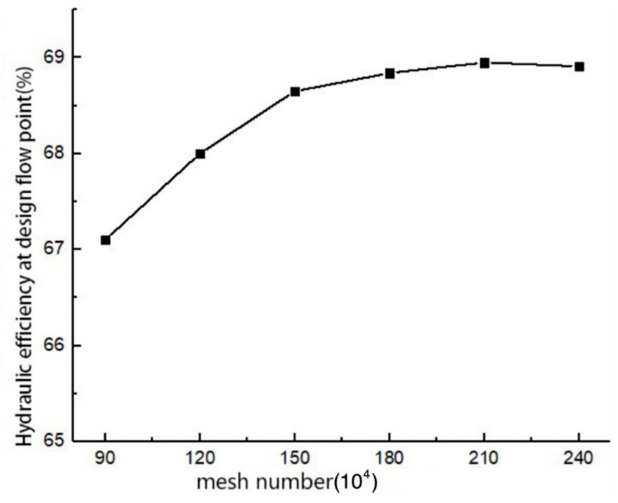
Figure 5. Mesh independence verification.